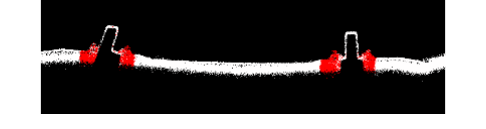
Figure 5. Section of KPConv semantic segmentation with transfer learning showing the misclassified points (in red) in the rails area (XZ view).